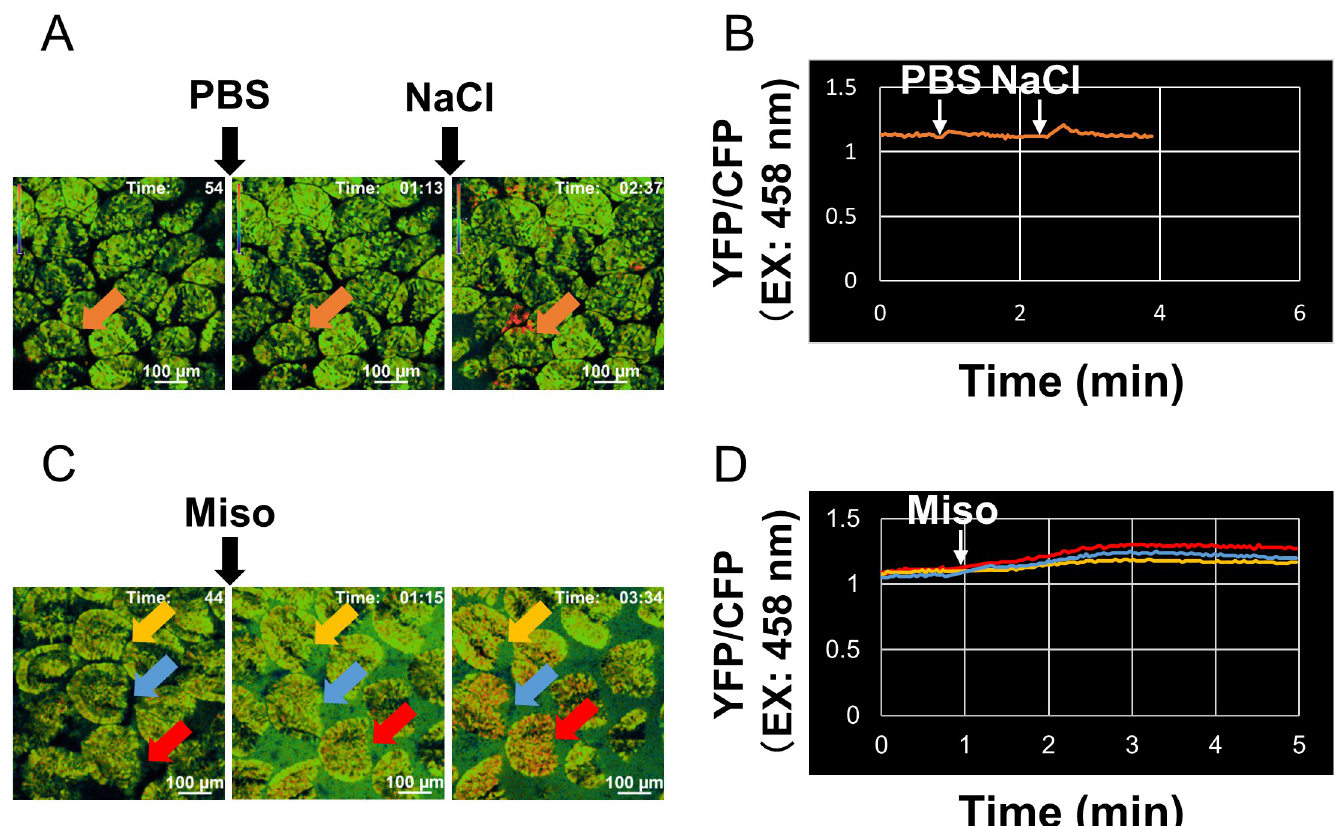
Fig 4. Images of intravital Ca 2+ signaling in the IECs of a mouse expressing YC3.60. (A) Representative Ca 2+ signaling of PBS and 1% NaCl images in the intestinal tract of a mouse with ubiquitous YC3.60 expression and SPF conditions. Ratiometric images (YFP/CFP at excitation of 458 nm) are shown. A total of 0.1 ml of PBS or 1% NaCl were added at the indicated time points. (B) Time course of fluorescence intensities of YFP/CFP upon excitation at 458 nm when the intestinal tract was stimulated with PBS and 1% NaCl. (C) Representative Ca 2+ signaling of PBS and 10% soybean-miso images in the intestinal tract of a mouse with ubiquitous YC3.60 expression and SPF conditions. Ratiometric images (YFP/CFP at excitation of 458 nm) are shown. A total of 0.1 ml of 10% miso in PBS was added at the indicated time point. (D) Time course for fluorescence intensities of YFP/CFP upon excitation at 458 nm when the intestinal tract was stimulated with miso and measured in randomly selected regions (n = 3). Scale bar, 100 μ m; frames = 131. Spontaneous Ca 2+ signals are indicated by arrows.